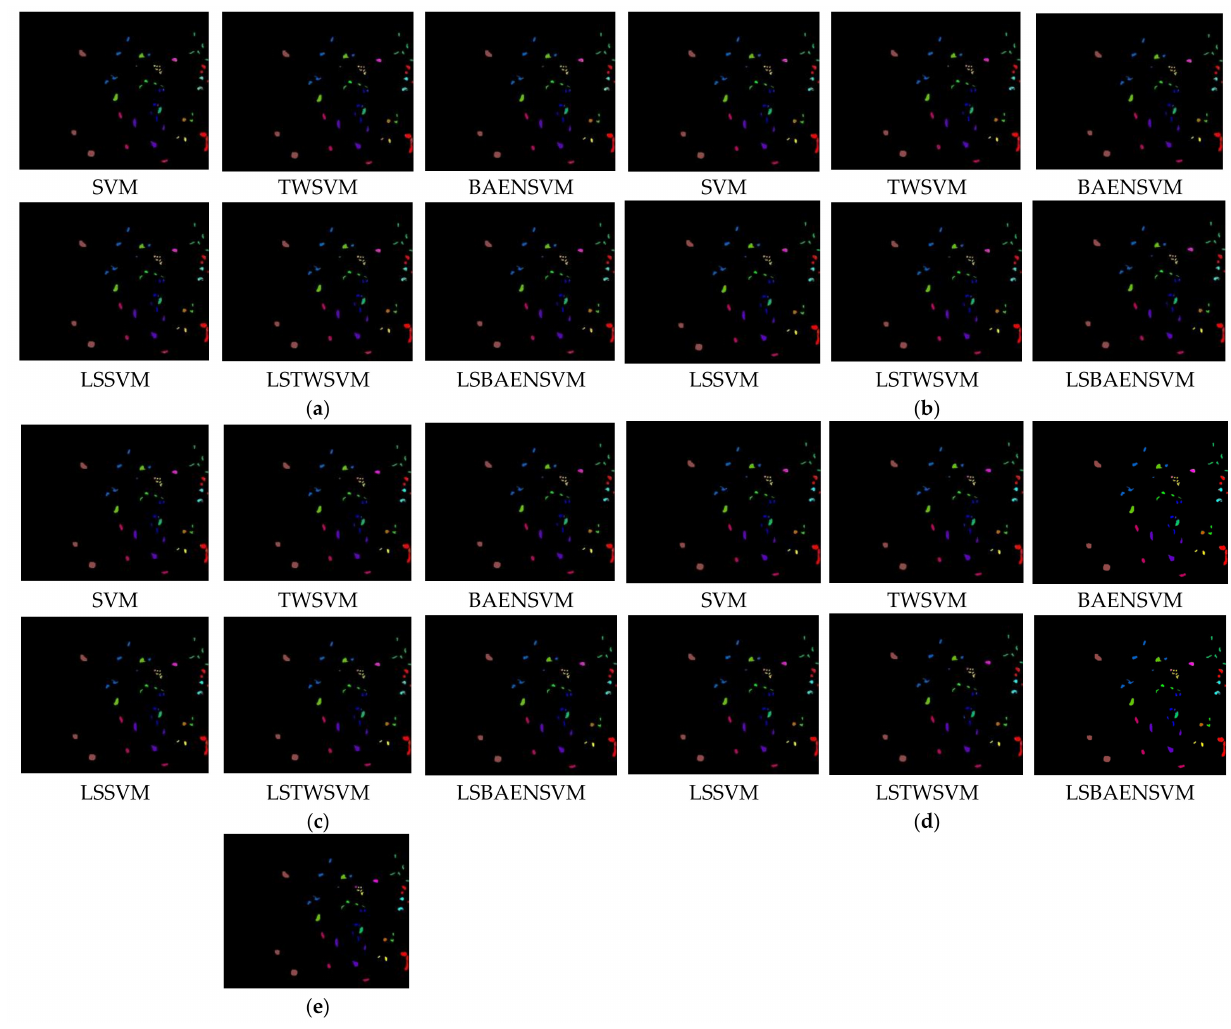
Figure 8. Kennedy Space Center hyperspectral image classification result image. ( a ) 10% KSC dataset, ( b ) 20% KSC dataset, ( c ) 30% KSC dataset, ( d ) 40% KSC dataset, ( e ) ground truth.